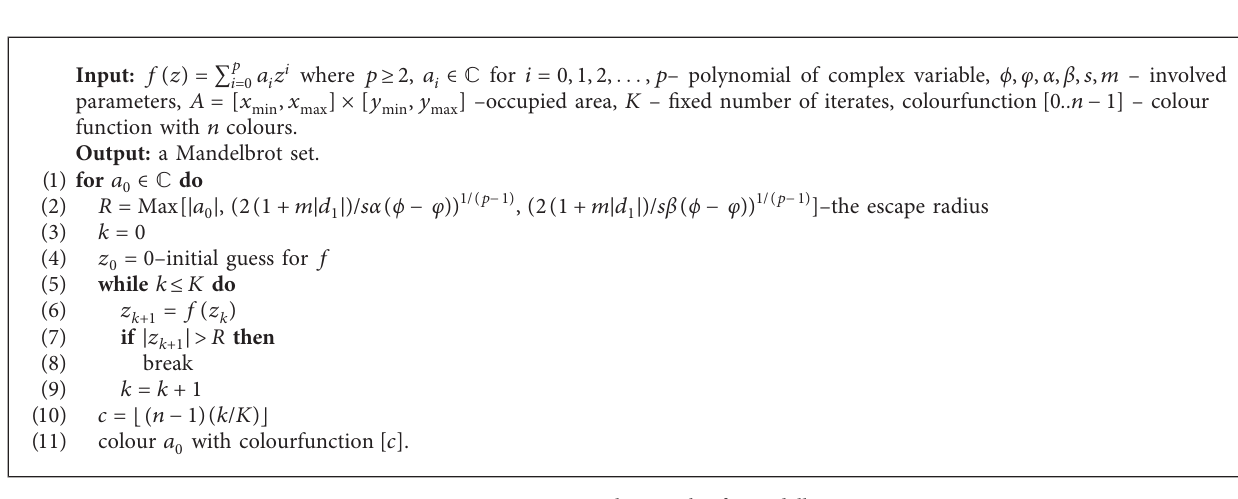
A LGORITHM 2: Complex graph of